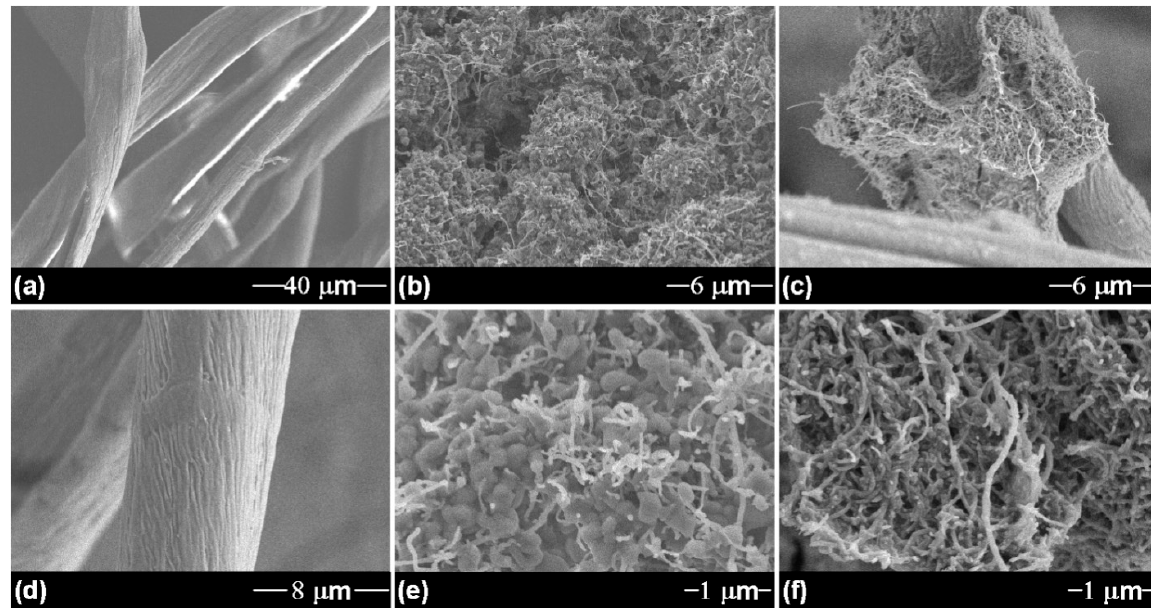
Figure 2. FE-SEM images of CBs ( a , d ), ZIF-8/CNTs/CBs ( b , e ), and C ZIF-8/CNTs/CCBs ( c , f ).